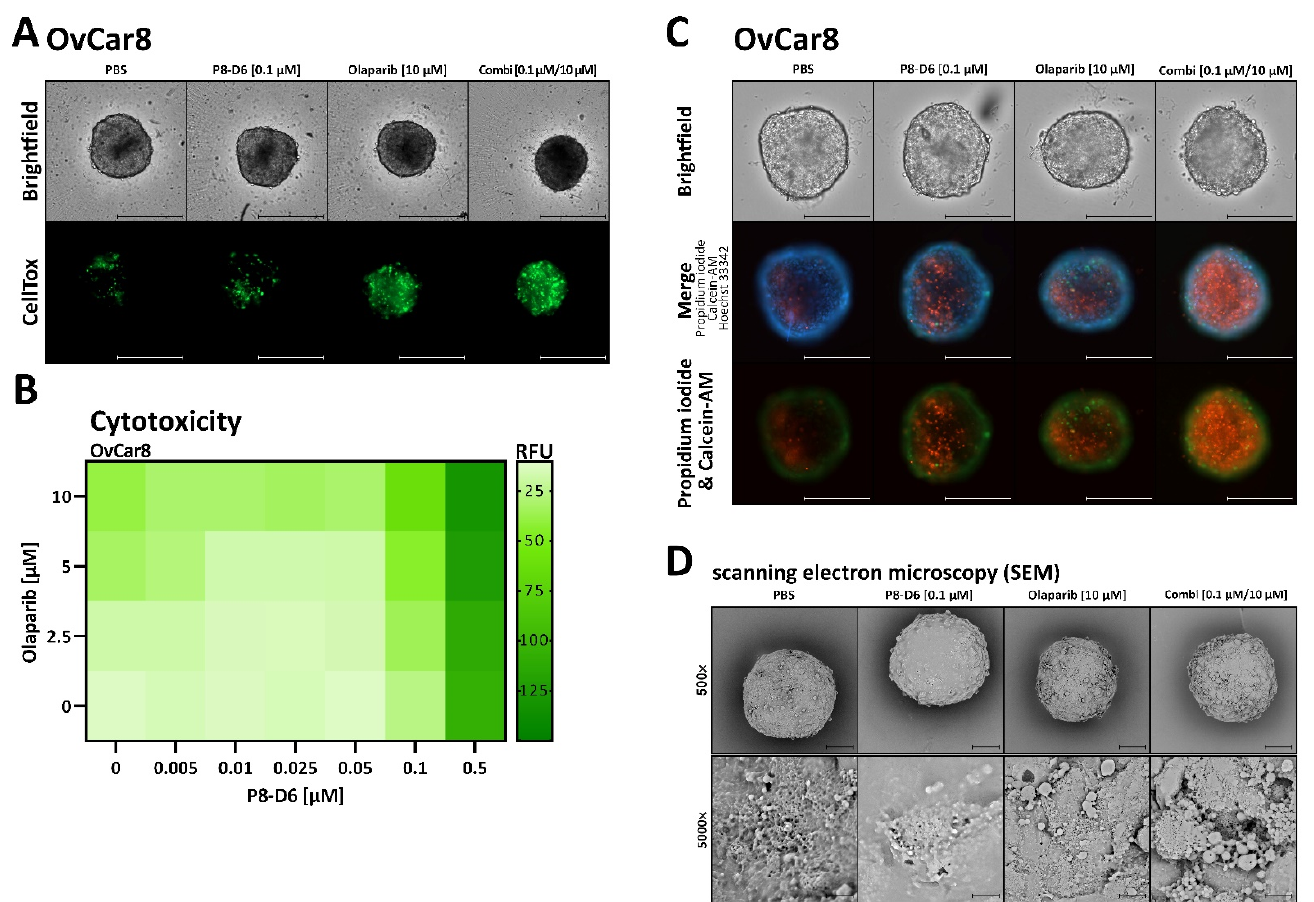
Figure 6. Toxicity of PARPi with dual topoisomerase inhibitor in 3D tumor spheroids of OvCar8. OvCar8 spheroids were maintained in ULA plates for 72 h and subsequently treated with olaparib and P8-D6 in single or combination treatment as described in the schedule in Figure 4A. ( A ) After treatment the cell toxicity was measured by fluorescence microscopy using CellTox™ Green (timepoint 144 h after seeding); scale bars, 500 µm. ( B ) The fluorescence signals after treatment were quantified (relative fluorescence units RFU) and shown in the heat map. ( C ) Spheroids were stained after treatment with PI (red), calcein-AM (green), Hoechst 33342 (blue) and imaged by fluorescence microscopy; scale bars, 500 µm. ( D ) Scanning electron microscopy images of spheroids, which were treated with P8-D6, olaparib, combination or PBS were taken; scale bars, 500 × 100 µm, 5000 × 10 µm.